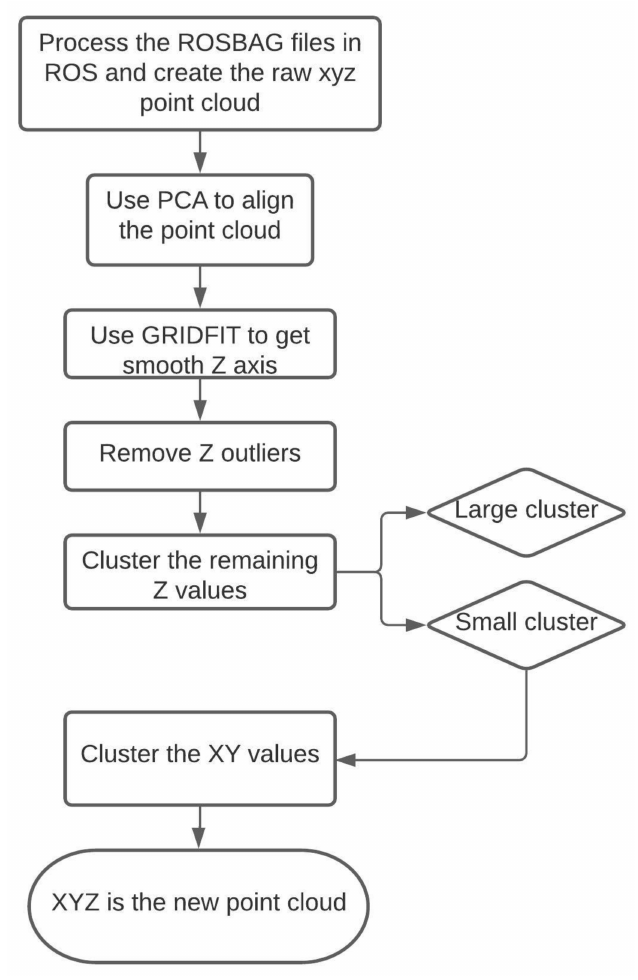
Figure 4. Schematic of the LiDAR data pre-processing